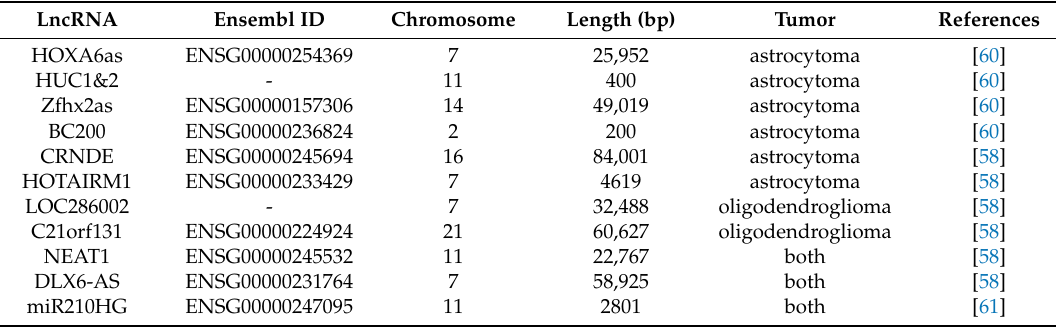
Table 1. LncRNAs with diagnostic potential in